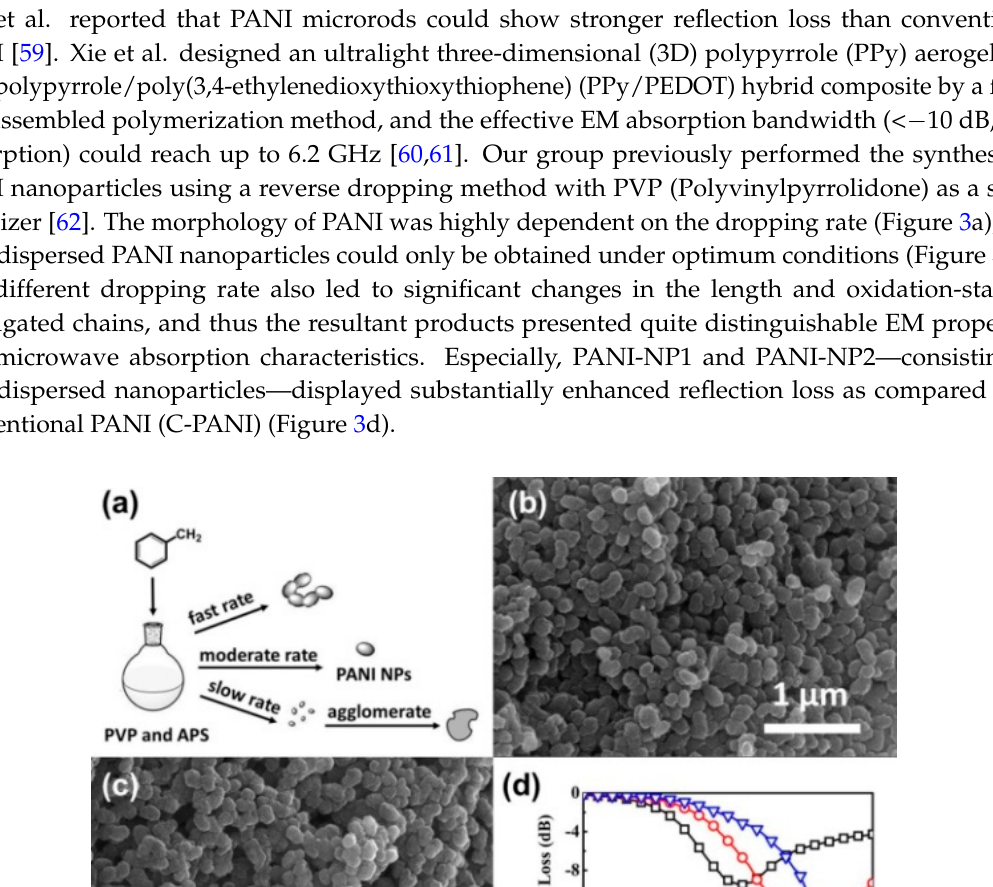
Figure 4. ( a ) TEM images of poly(3,4-ethylenedioxythioxythiophene (PEDOT) solid spheres, ( b ) single-shelled PEDOT hollow spheres, ( c ) double-shelled PEDOT microspheres, and ( d ) triple- shelled PEDOT microspheres; ( e ) Reflection loss for different morphologies of PEDOT microspheres in the frequency range of 8.0–18.0 GHz with a thickness of 2 mm. Reprinted with permission from Reference [34].